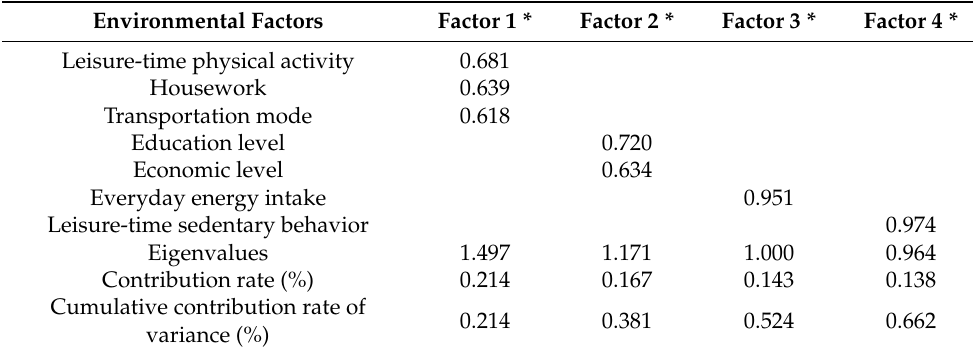
Table 2. Factor analysis of obesity-related environmental factors.